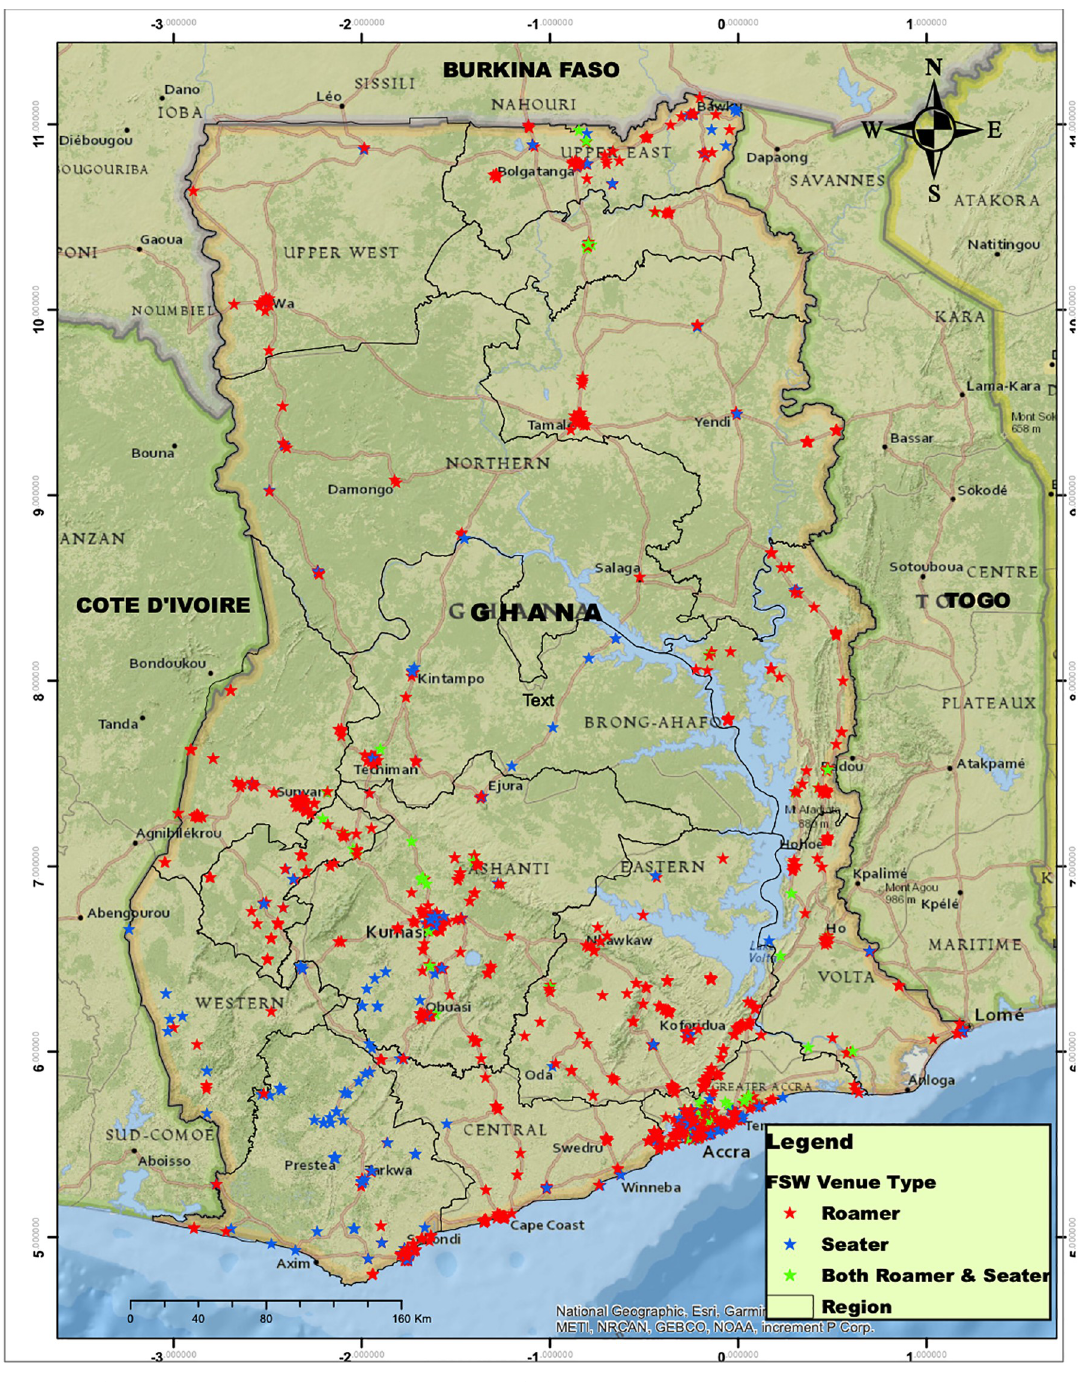
Fig 2. Distribution of FSW venue types among the 16 regions of Ghana,